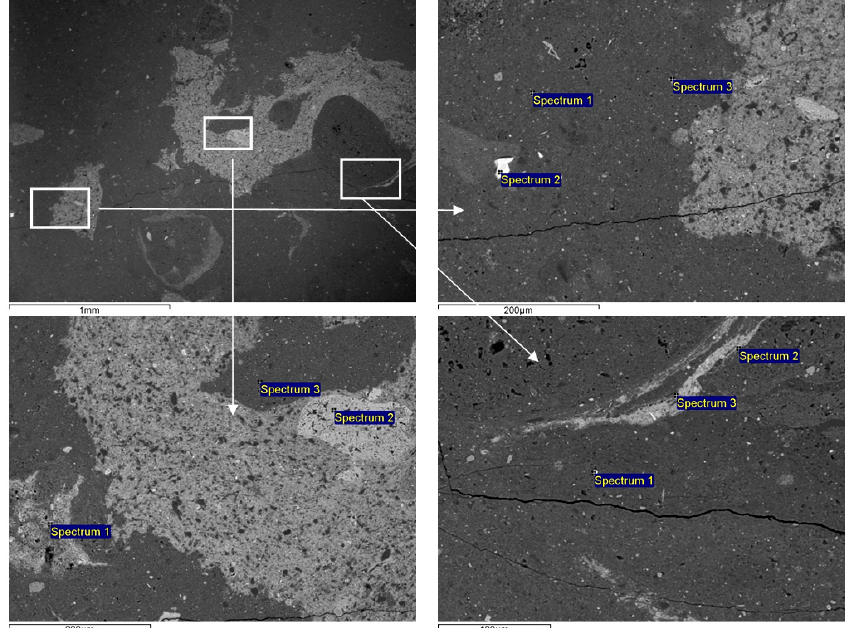
Figure 9. Bauxite deposit Štitovo II. Analysed field 1—sample 099, with details and analysed points. Spectrum 1,2—Zircon; Spectrum 3—Anatase; Spectrum 4—Fe-hydroxides; Spectrum 5—Hematite; Spectrum 6—Al–hydroxides; Spectrum 7—Xenotime; Spectrum 8—Al + Fe–hydroxides ; Spectrum 9—Zircon + Al–hydroxides.